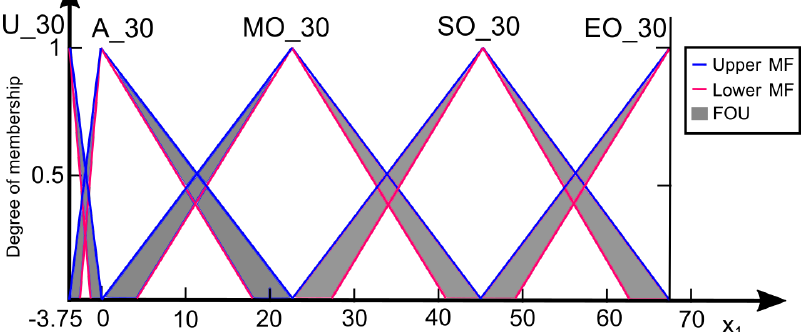
Figure 5. Input variable Average assessment of speed 30 km/h. Used notation: MF—membership function; FOU—footprint of uncertainty.